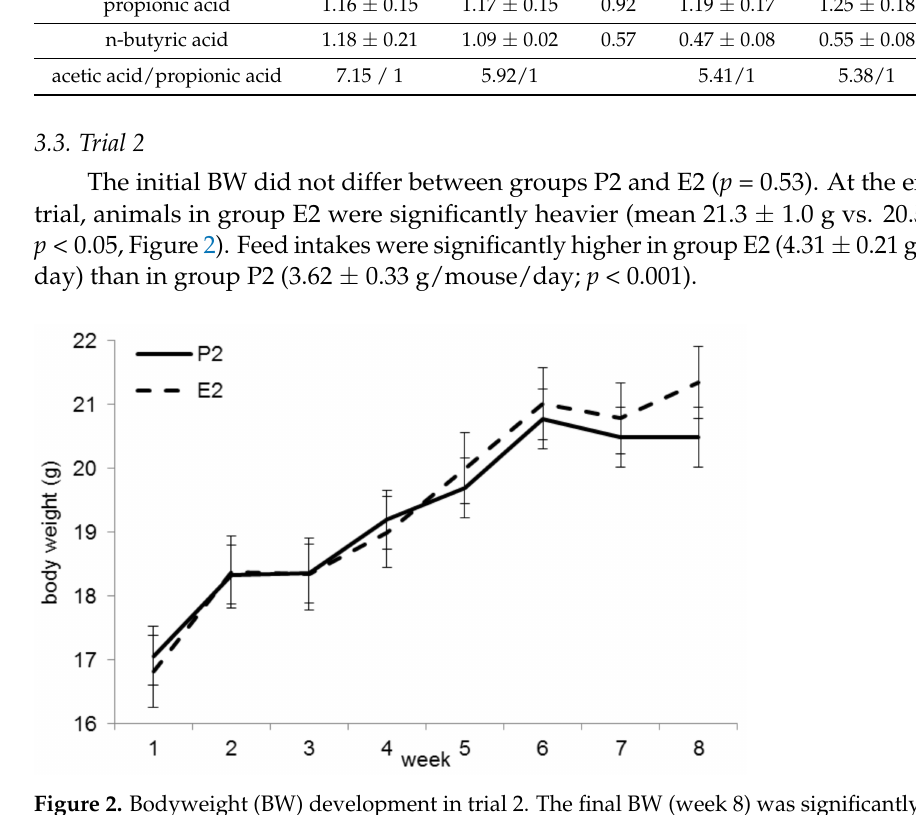
Figure 2. Bodyweight (BW) development in trial 2. The final BW (week 8) was significantly higher in group E2 ( p <